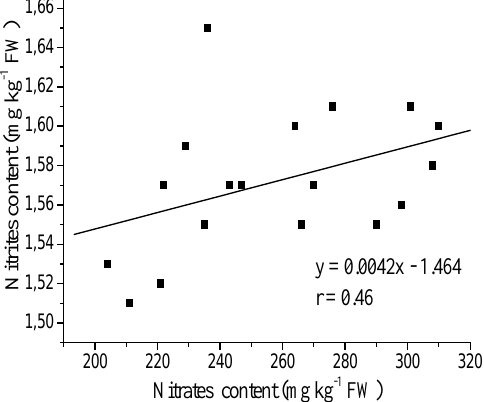
Figure 8. The significant relationship between nitrates content and nitrites contents in the potato after 6 months of storage. R: p ≤ tubers after 6 months of storage. R: p ≤ 0.05.